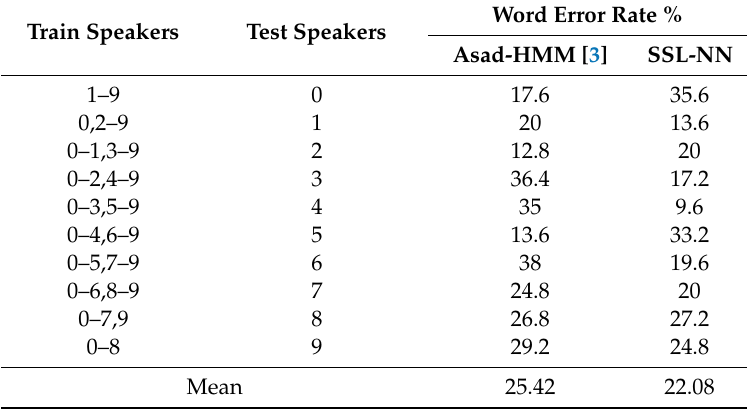
Table 3. Word Error Rate (WER) comparison with Asad-Hidden Markov Models (HMMs) [3]. Train Speakers Test Speakers